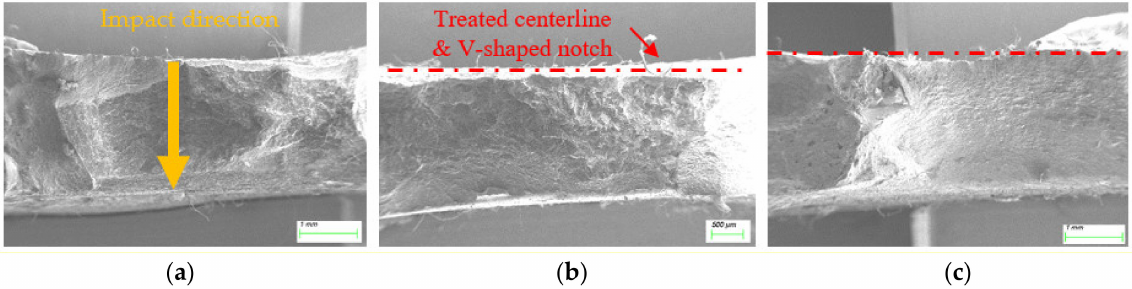
Figure 7. Fracture surfaces ( a ) and ( b ) deviating from the EP-treated centerline; and ( c ) full of poles.